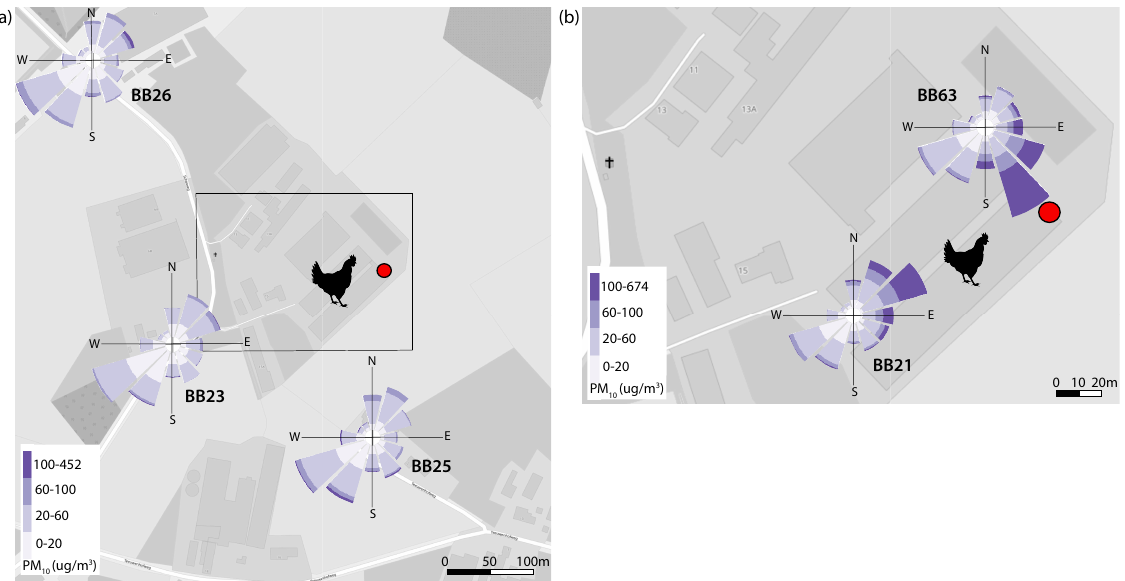
Figure 5. PM 10 pollution roses recorded by sensors in Leunen at ( a ) residential locations and ( b ) on the farmer’s premises. The average concentration of PM per wind sector is shown by the roses, weighted according to how often wind came from this direction during the period analysed. The locations of chicken stables are indicated by the chicken symbol, and the location of the stable exhaust fan is indicated by the red dot. ©OpenStreetMap